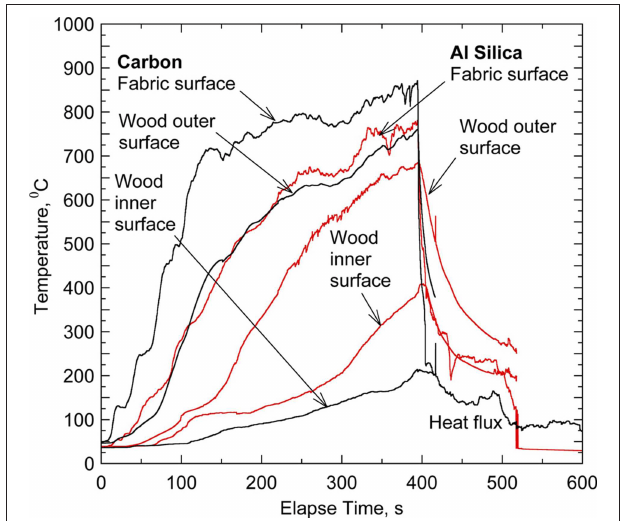
FIGURE 3 | Temporal variations in the measured temperatures in the blanketed wooden structure. Red, aluminized amorphous silica; black, pre-oxidized carbon.